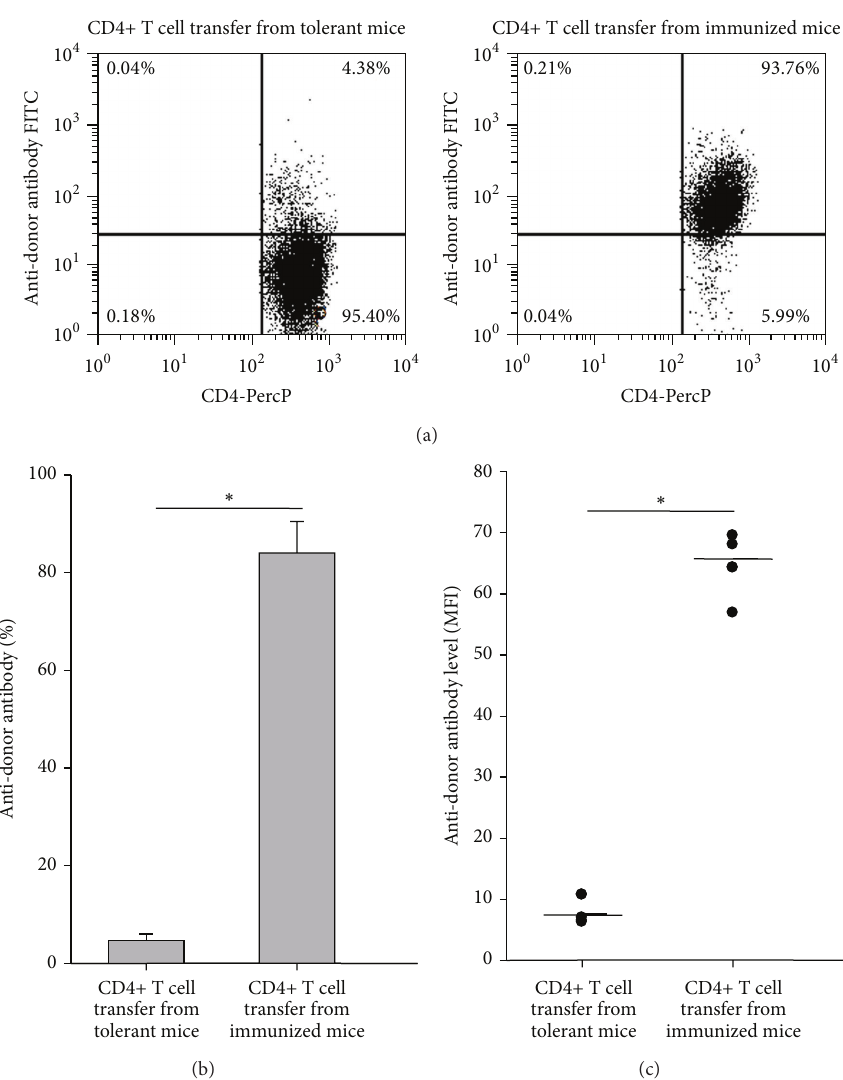
Figure 2: Alloantigen immune tolerance is transferable by adoptive transfer of CD4+ T cells from long-lasting tolerant mice. Splenic CD4+ T cells from C3H mice used for the experiments in Figure 1 were prepared by negative selection using Easysep kits from StemCell Biotechnology Company. Given that all mice had been challenged by injection of Balb/c spleen cells, the PBS-treated C3H mice were all immunized as shown inFigure 1,andthetwogroupsweredesignatedastolerantgroupandimmunizedgroup,respectively.CD4+Tcellswereadoptivelytransferred into na¨ıve C3H mice ( 5 × 10 6 CD4+ T cells/mouse) (5 mice/group). One day after CD4+ T cell transfer, all mice were challenged with two weekly transfusions of 2 × 10 5 Balb/c spleen cells. One week after the second antigen challenge, the development of antibodies against donor Balb/c WBCs was examined as described in Section 2. (a) A representative of each group was shown. ((b) and (c)) The summary of anti-donor antibody levels in percentage and MFI of each group was depicted, respectively. Data represent mean ± standard error. ∗ 𝑃 < 0.05 . The 𝑃 values were calculated using Student’s 𝑡